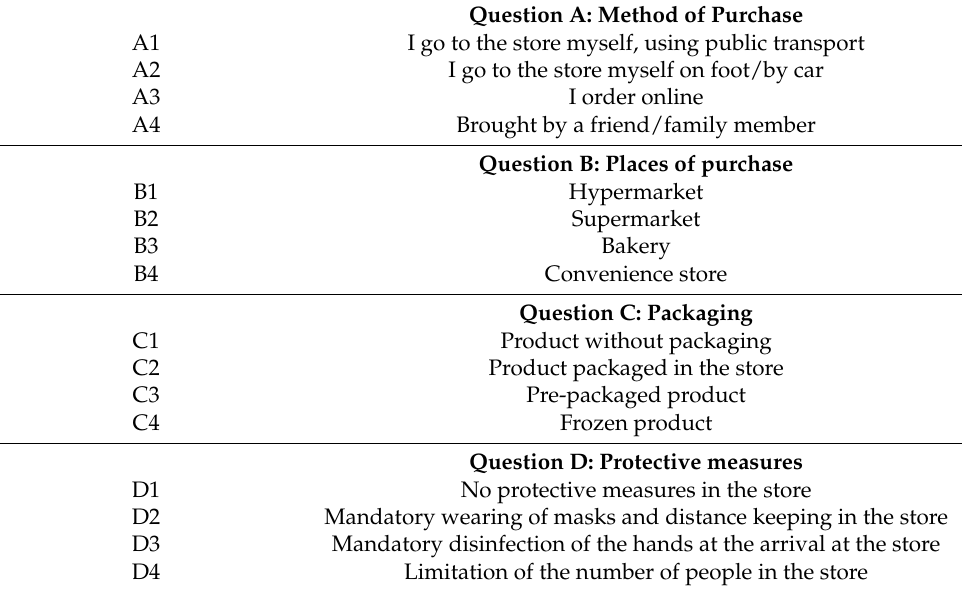
Table 1. Silos (questions) and elements (answers) used in the BimiLeap ® study. Question A: Method of